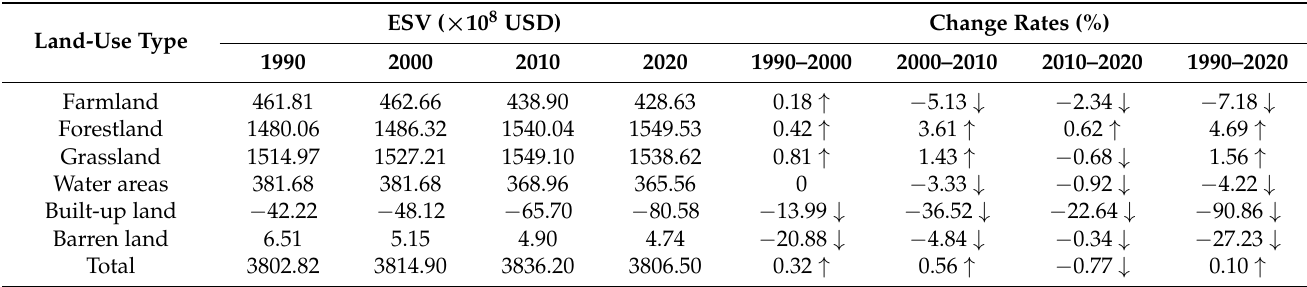
Table 5. Changes in the ESV of different land-use types in Shaanxi Province from 1990 to 2020. Land-Use